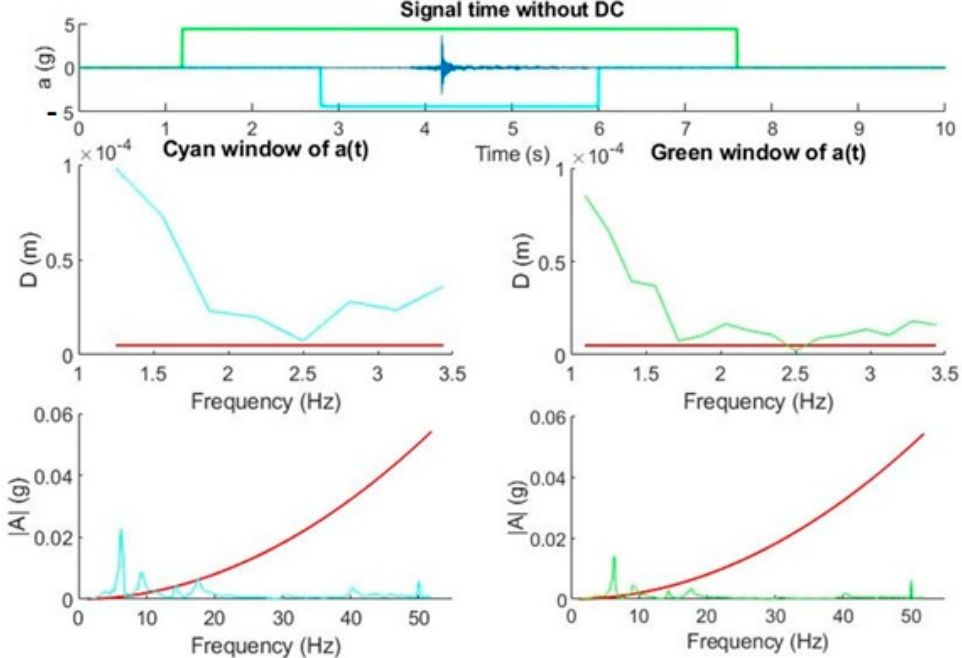
Figure 11. Graphs (acceleration-frequency and displacement-frequency). Straight ascension